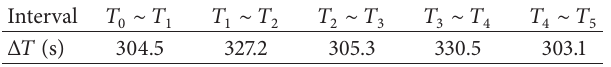
Table 10: Flight time in each trajectory interval (Case 3).